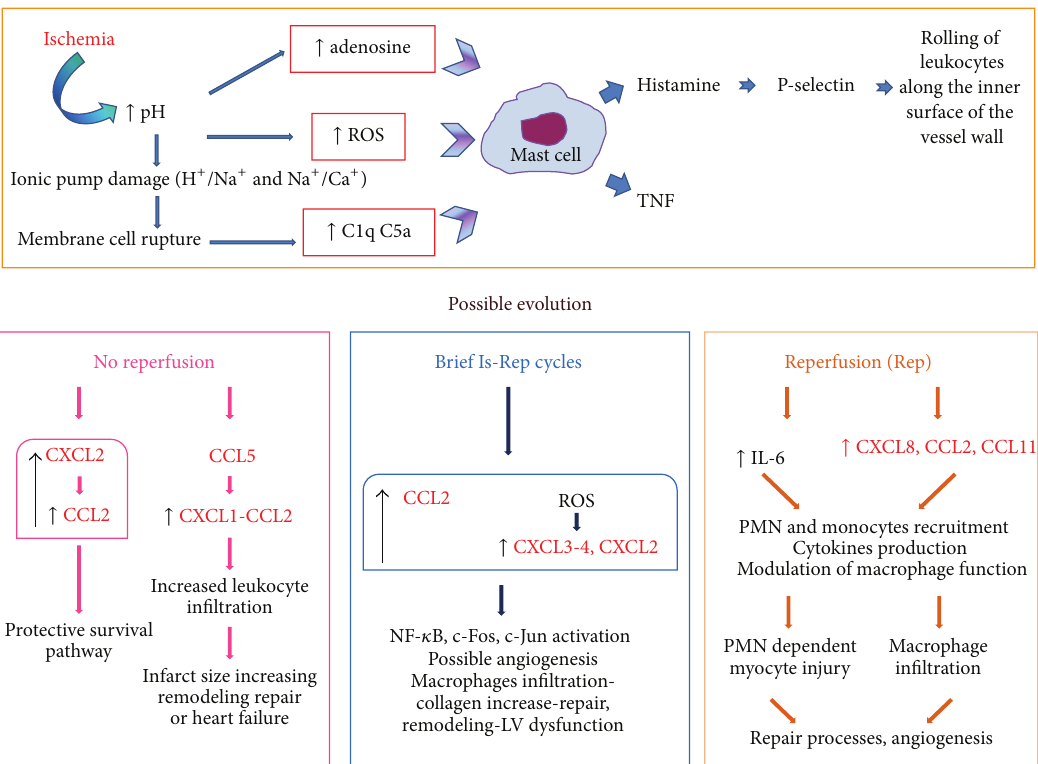
Figure 2: Metabolic changes triggered by ischemic insult and possible evolutions of the injury with the crosstalk between chemokines. The pH decrease, provoked by ischemia, is the event turning on the process. The cell membrane is damaged and debris activates the classic complement pathway in the infarcted myocardium. ROS, adenosine, and complement activate mast cells to produce TNF and histamine, leading to leukocyte recruitment from the vessels. Depending on the presence or the absence of reperfusion, there is a different crosstalk between chemokines, aimed at restoring the balance. Dysregulated or exaggerated responses may actually lead to a progression of the disease (see text for details, chemokines in